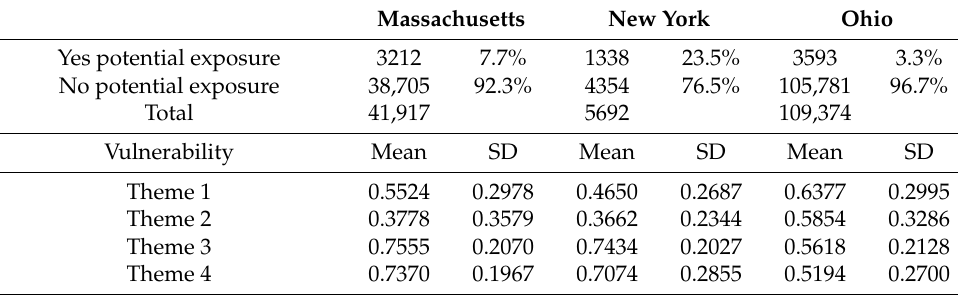
Table 4. Thematic vulnerability by exposure to SARS-CoV-2 and